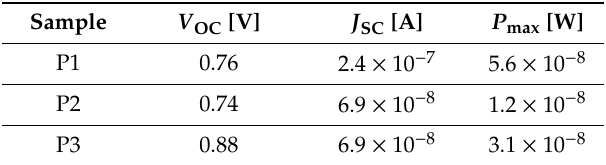
Table 2. Electrical parameters of the MAPLE-deposited organic layers.